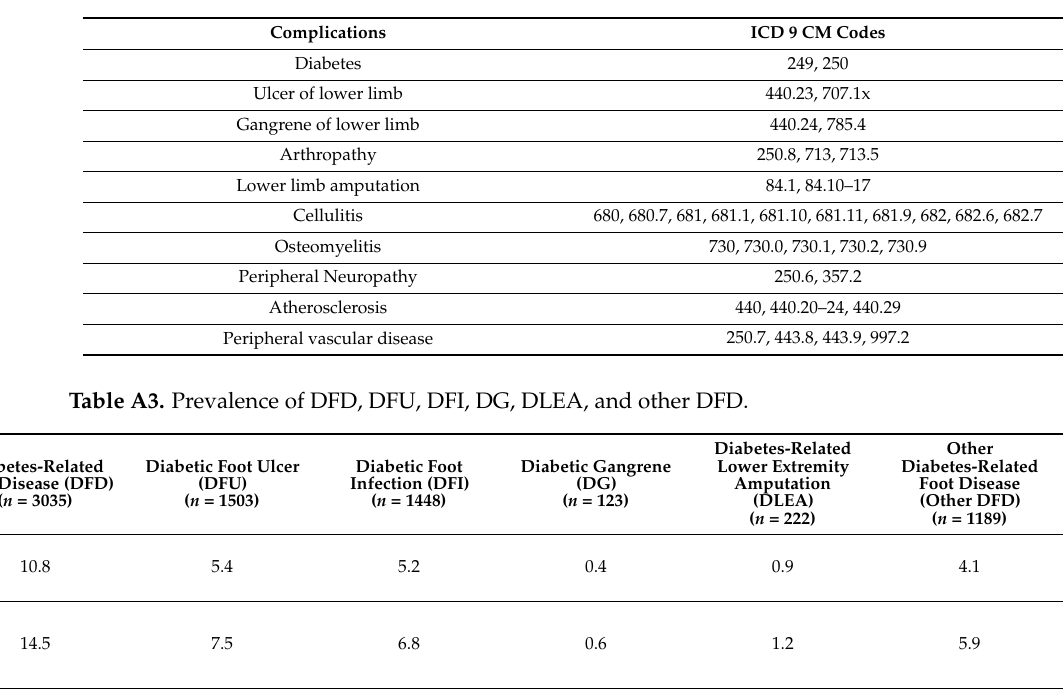
Table A2. ICD-9 CM codes for diabetes-related foot disease.